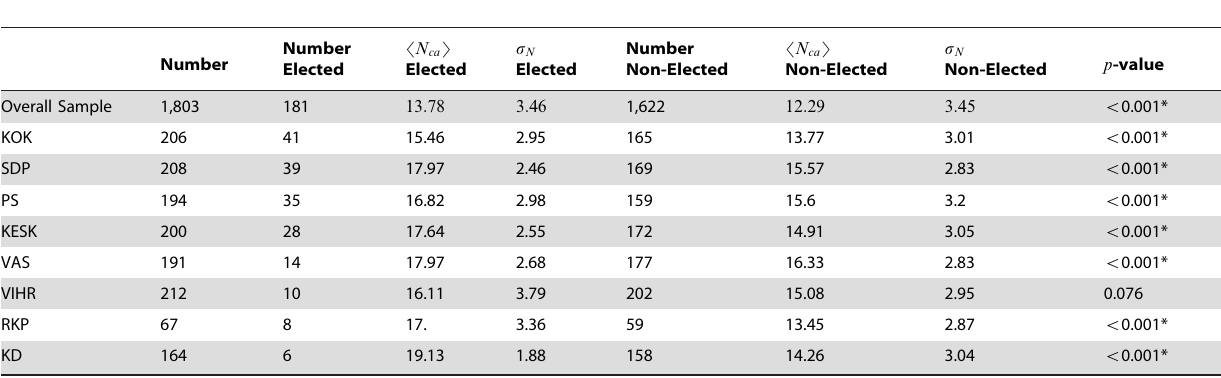
Table 4. Summary statistics of the number of common answers N ca present in the political profile of elected and non-elected candidates, disaggregated by party.